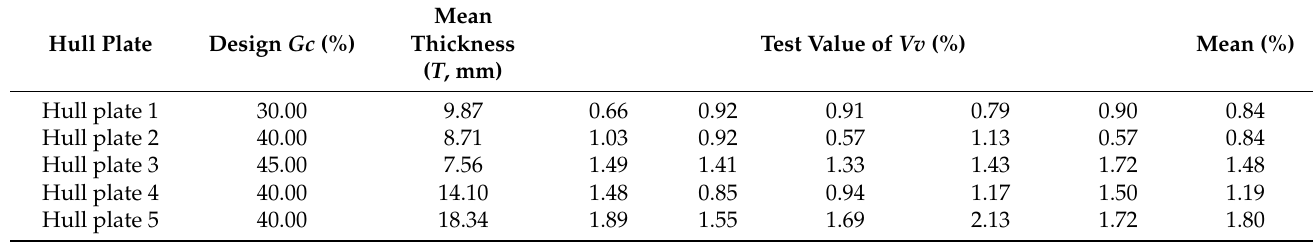
Table 6. Vv values of the hull plate specimens according to burn-off testing.